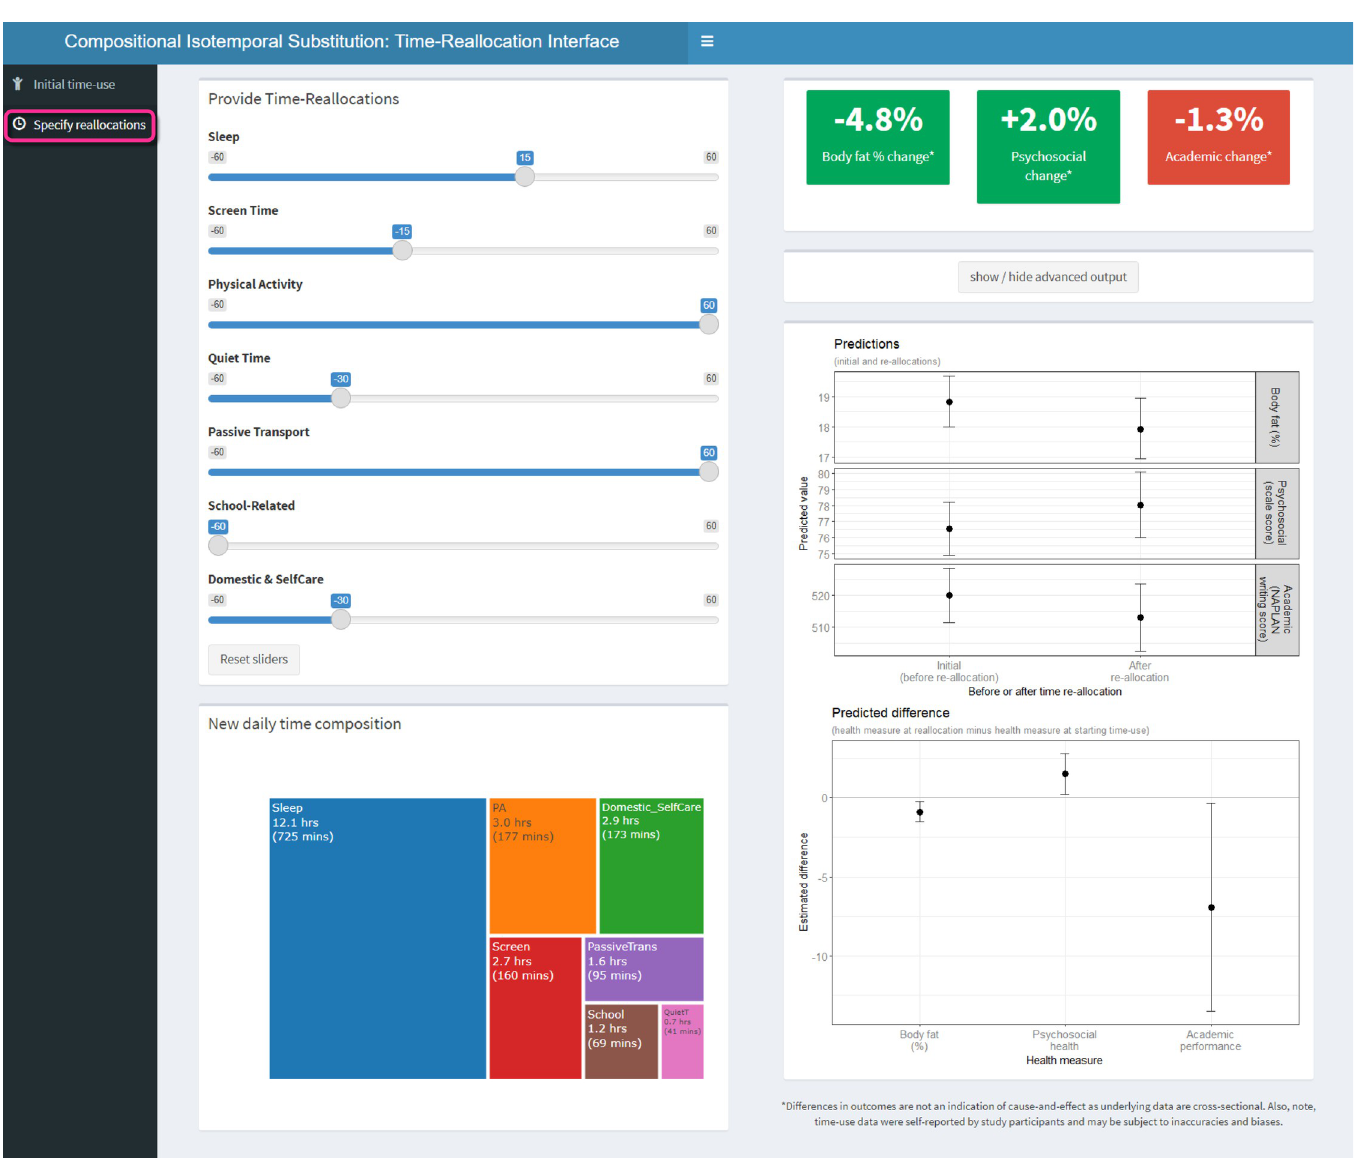
Fig 4. Specification of complex time-use reallocations using the app, and visualization of advanced output. Initial time-use composition was the compositional mean of the sample: Sleep = 11 h 50 min; Screen time = 2 h 55 min; Physical activity = 1 h 57 min; Quiet time = 1 h 11 min; Passive transport = 35 min; School-related activities = 2 h 09 min; Domestic/self-care activities = 3 h 23